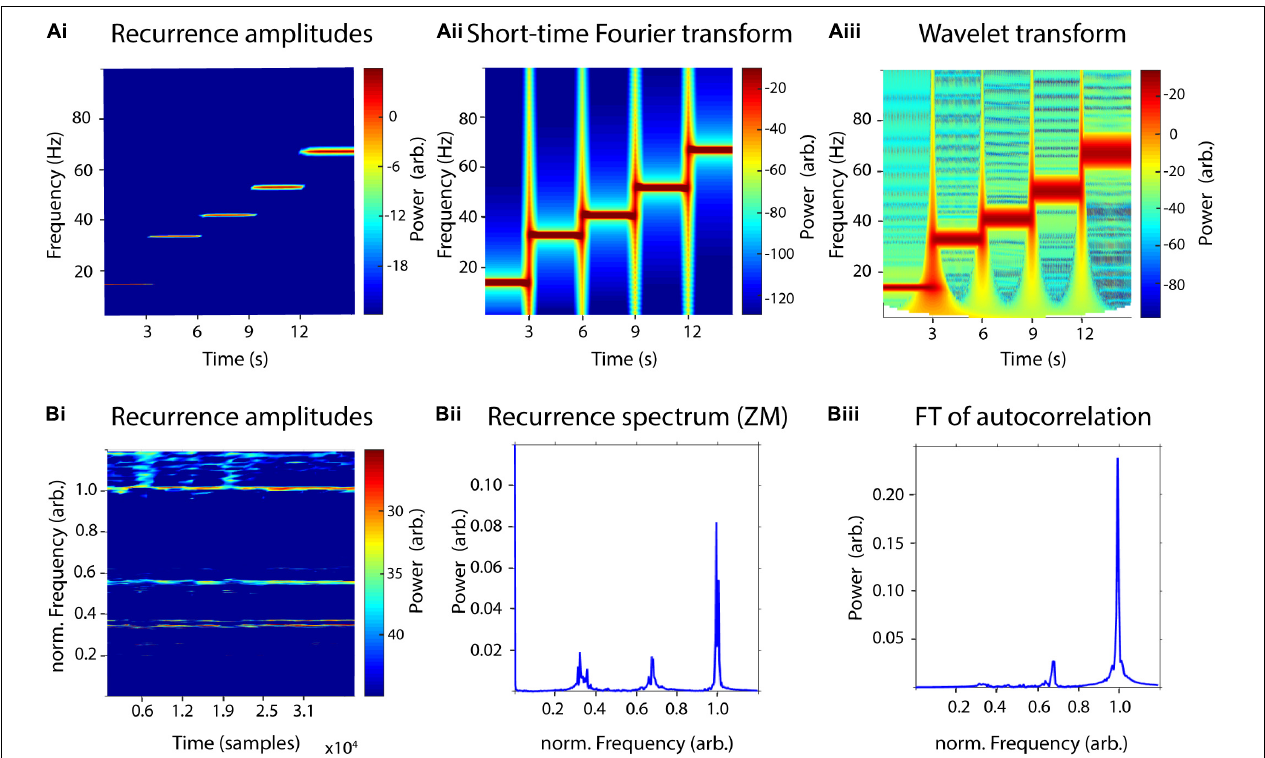
FIGURE 5 | Sensitivity to time-frequency transitions and multiple high-order frequencies. (A) Comparison of a time-resolved recurrence amplitude spectrum (Ai) with short-time Fourier transform (Aii) and wavelet transform (Aiii) using a concatenated signal of five 3-s segments with increasing frequencies (14, 33, 41, 52, and 67 Hz). (B) Comparison of a time-resolved recurrence amplitude spectrum (Bi) with a time-independent recurrence spectrum proposed by Zbilut and Marwan (2008) (Bii) and the Fourier transform of the autocorrelation function (Biii) of 40,000 samples of the Belousov–Zhabotinsky chemical reaction. The period-3 orbit between the frequencies of 0.3 and 0.4 can only be detected in panels (Bi,Bii) . Frequencies were normalized to the fundamental period of the system at 125